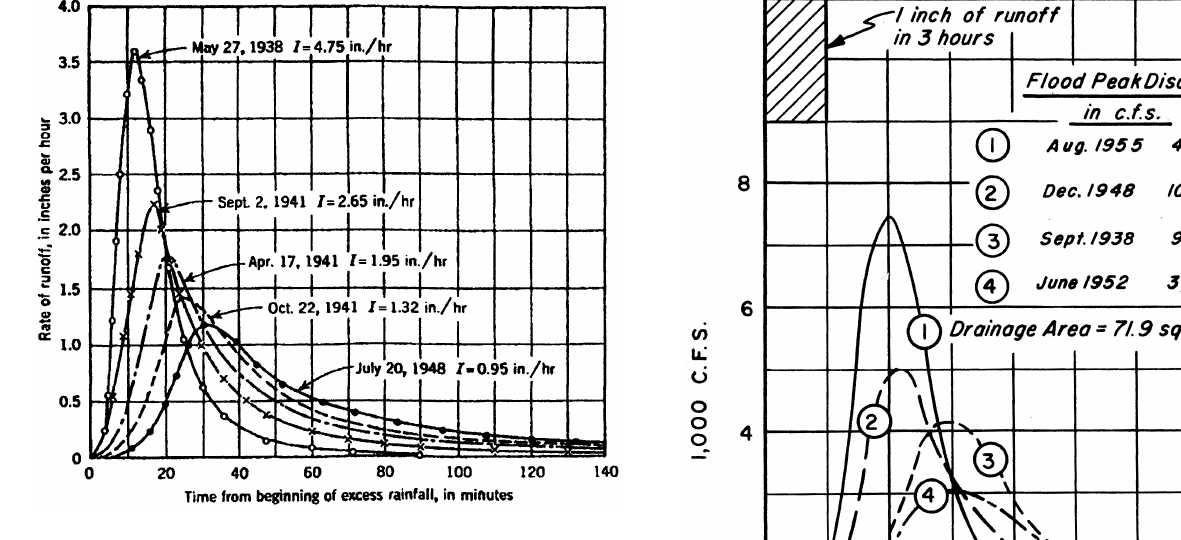
Fig. 1. The Minshall family of unit hydrographs for the Ed- wardsville, Illinois, watershed, USA. (Reprinted with permission of ASCE.)